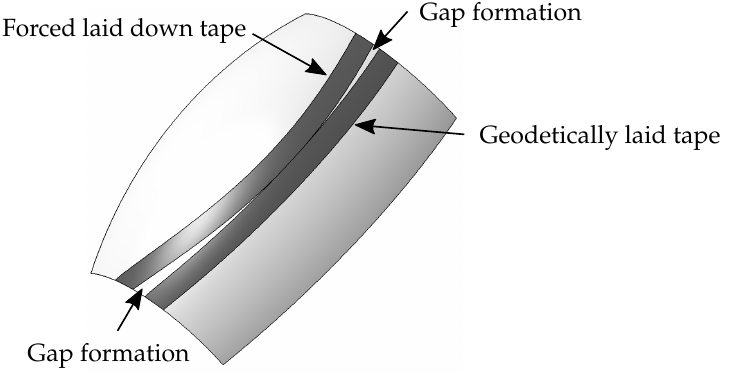
Figure 3. Gap formation through forced